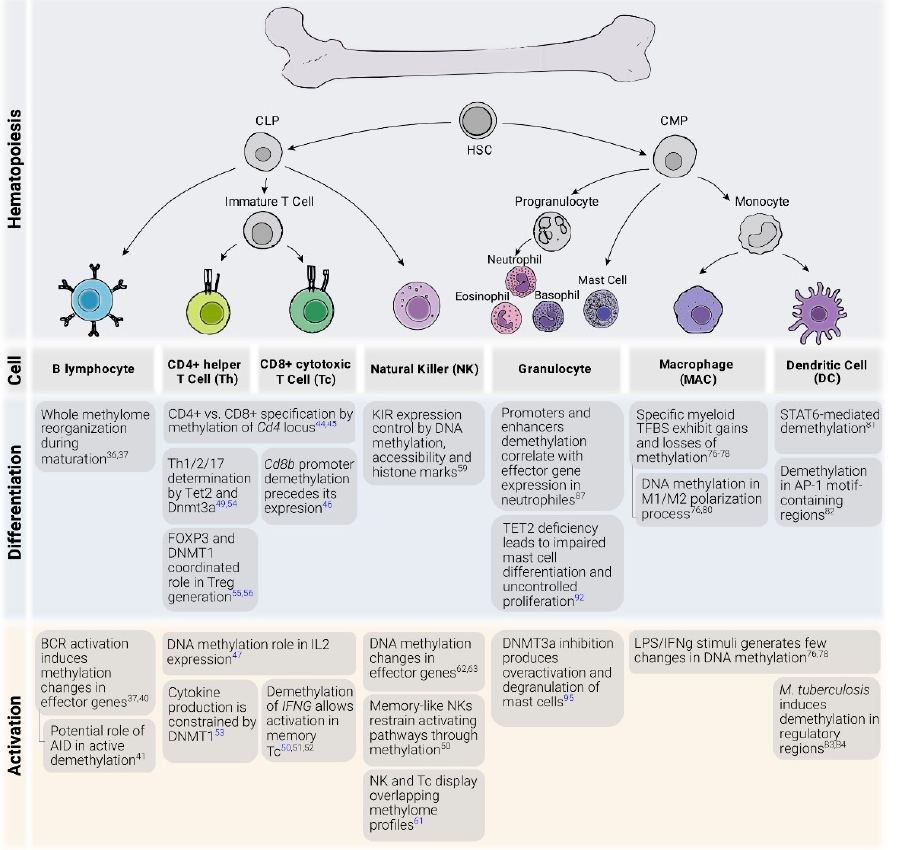
Figure 1. DNA methylation regulation processes in immune cell function, differentiation and activation. HSC: hematopoietic stem cell, CLP: common lymphoid progenitor, CMP: common myeloid progenitor, Th: CD4+ T helper cell, Tc: CD8+ cytotoxic T cell, NK: natural killer cell, MAC: macrophage, DC: dendritic cell. BCR: B cell receptor, KIR: Killer cell immunoglobulin-like receptor, TFBS: Transcription factor binding site, LPS: Lipopolysaccharide. In blue, references of studies in mice. In black, references of studies in human.